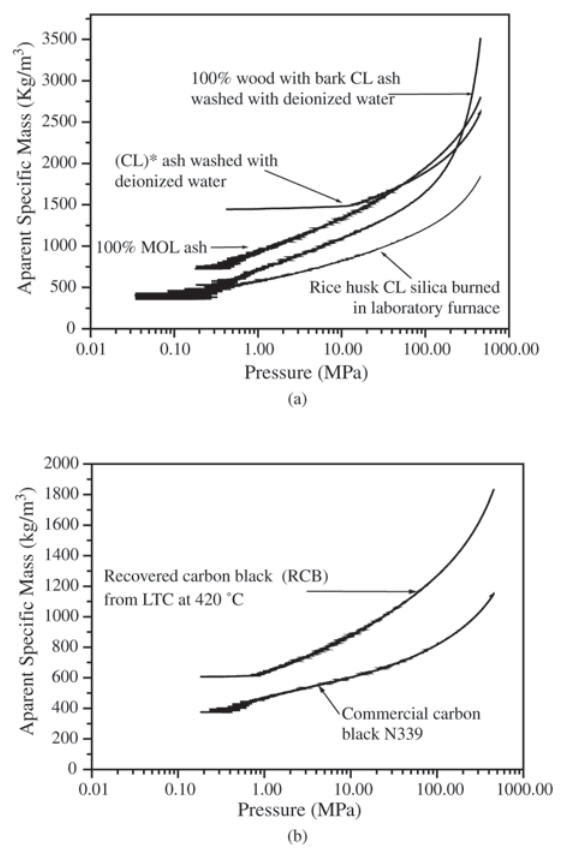
Figure 4. Compaction curves for some powders produced by the Biomass Refinery: a) Compaction curves of ashes and silica; b) Compaction curves of recovered and commercial N339 carbon